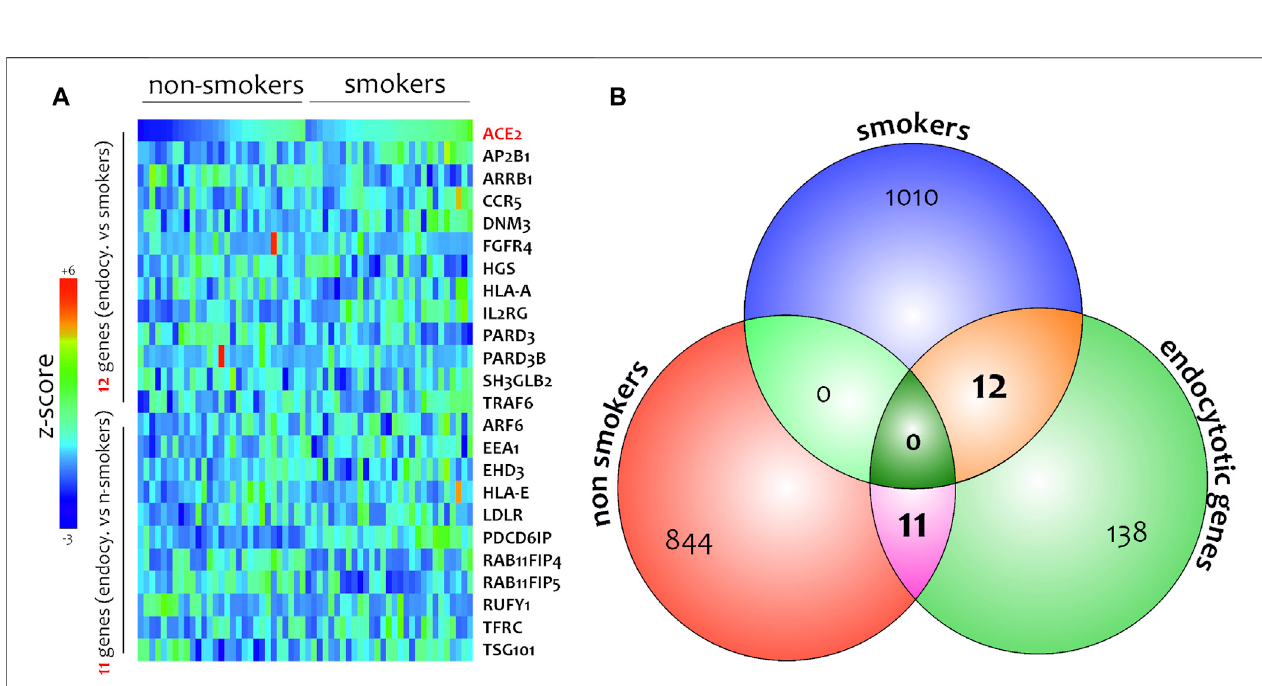
FIGURE 9 | Heatmaps of genes highly related to ACE-2 in SAE cells isolated from non-smokers and smokers (A) . Venn diagram performed between gene highly correlated to ACE-2 in non-smokers, smokers, and main genes belonging to endocytic process (B) .